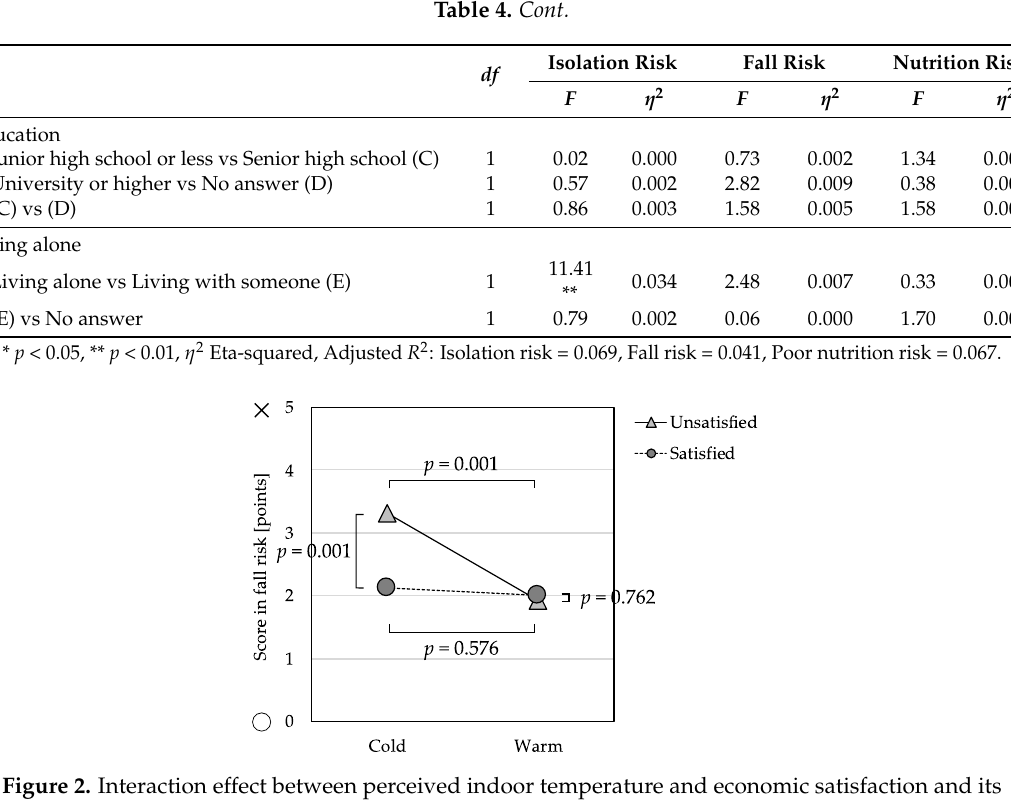
Figure 2. Interaction effect between perceived indoor temperature and economic satisfaction and its relation to fall risk score ( n =